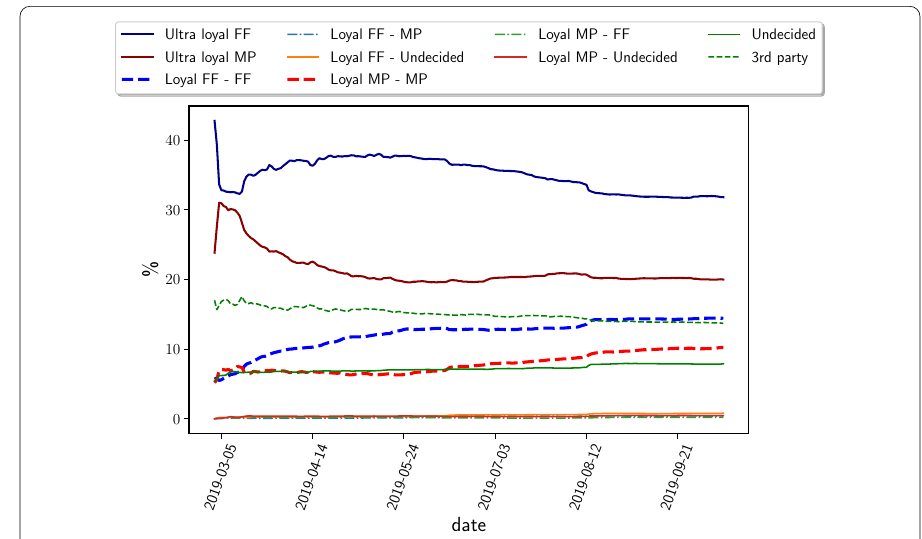
Fig. 12 Cumulative users’ opinion trends for each loyalty class over